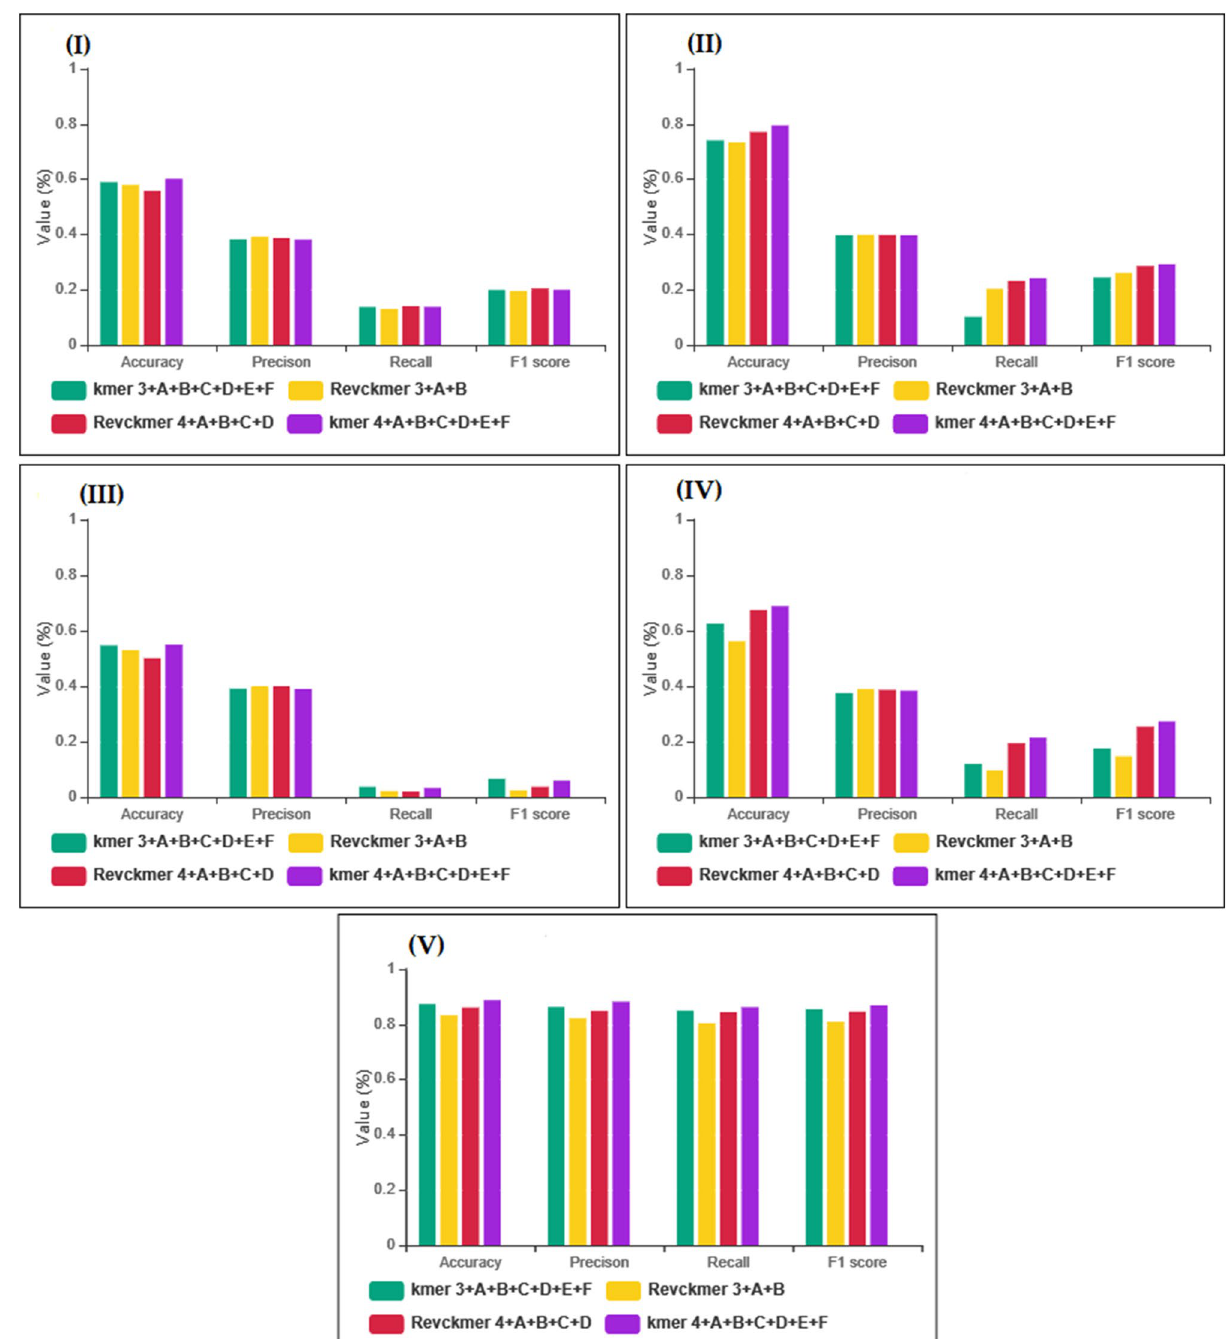
Figure 1. The comparison of the prediction performance of our model and four machine learning algorithms on four different datasets. Where Kmer 3 is 3mer frequency, Kmer 4 is 4mer frequency, Revckmer 3 is reverse complement 3mer, and Revckmer frequency 4 is reverse complement 4mer frequency for aptamer properties. For protein properties: A indicates hydrophobicity, hydrophilicity, and mass; B indicates polarity, molecular weight, and melting point; C indicates transfer free energy, buriability, and bulkiness; D indicates solvation free energy, relative mutability, and residue volume; E indicates volume, amino acid distribution, and hydration number; F indicates isoelectric point, compressibility, and chromatographic index. ( I ) is results of k nearest neighbor algorithm; ( II ) is results of random forest algorithm; ( III ) is results of support vector machine algorithm; ( IV) is results shallow neural network algorithm and ( V ) is results of our model. The power of predictors is calculated based on four metrics, including accuracy, precision, recall, and